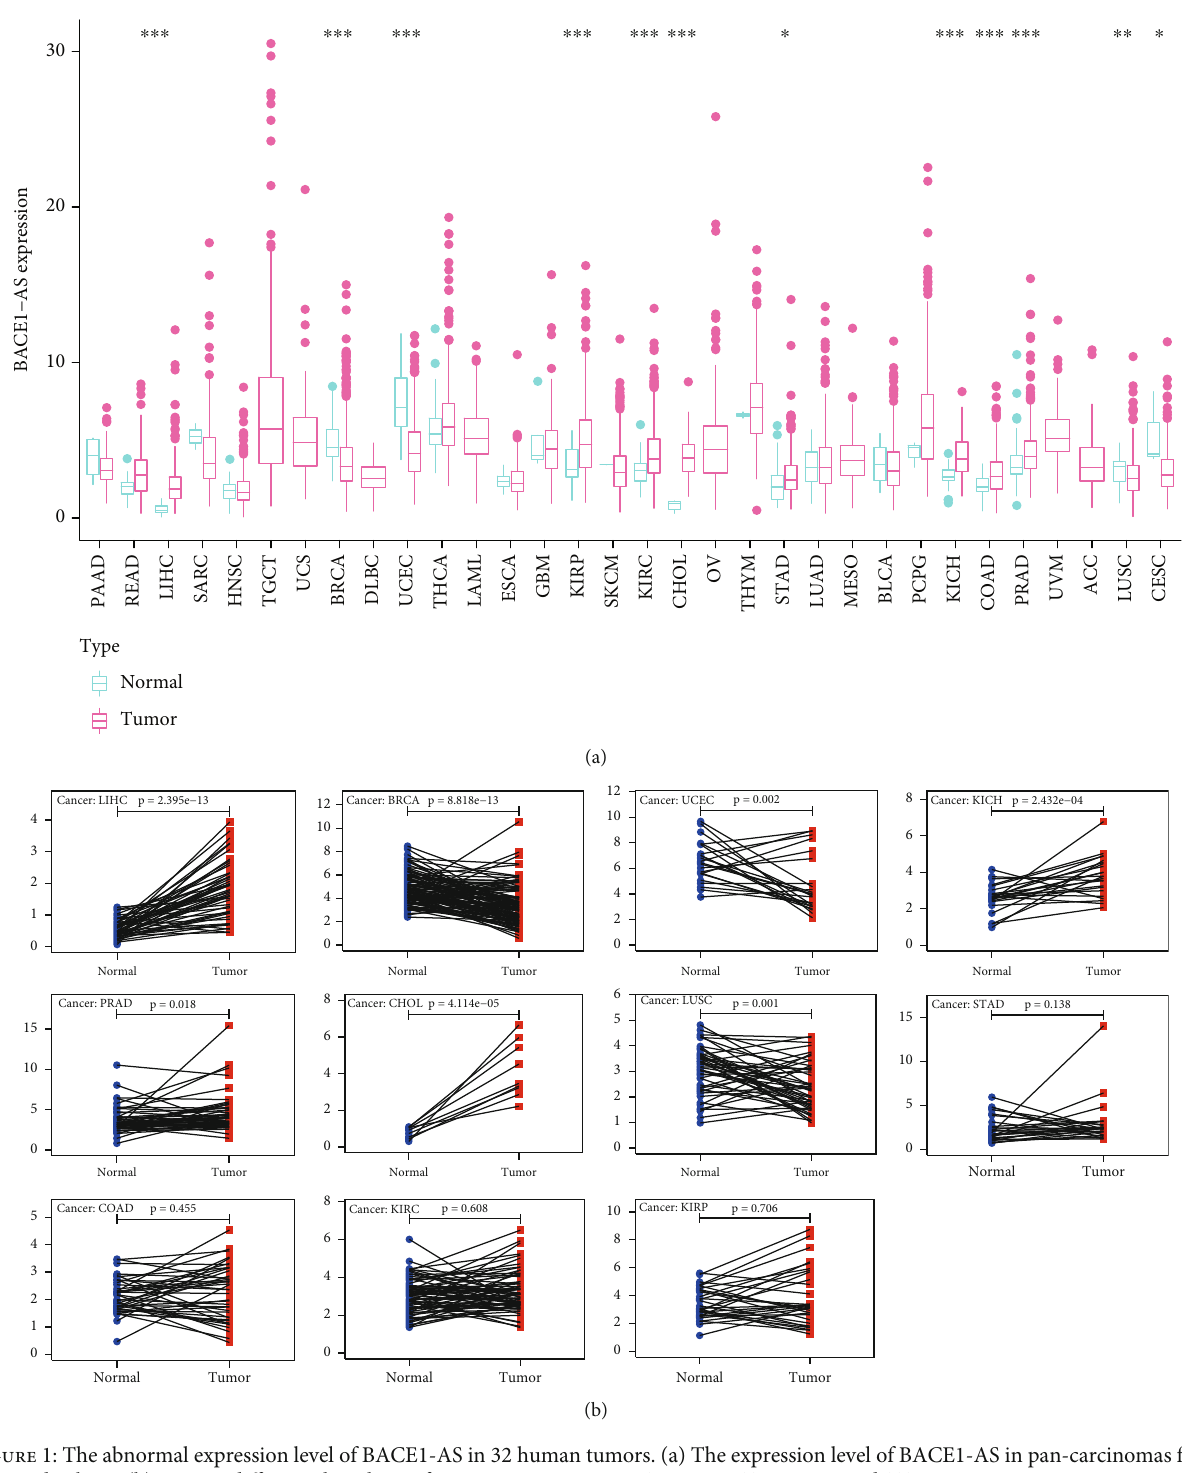
Figure 1: The abnormal expression level of BACE1-AS in 32 human tumors. (a) The expression level of BACE1-AS in pan-carcinomas from TCGA database. (b) Pairing di ff erential analysis of BACE1-AS in tumors. ∗ P < 0 : 05 , ∗∗ P < 0 : 01 , and ∗∗∗ P < 0 : 001 had longer overall survival (OS), while the opposite was 3.2. The Prognostic Value of BACE1-AS in Pan-Cancer. The detected in PAAD and UVM patients (Figure 2(a)). The correlations between BACE1-AS expression levels and the PFI analysis (Figure 2(b)) found that longer progression- prognosis of di ff erent cancers are depicted in Figure 2 free intervals were associated with lower expression of and Supplementary Figure 1. Patients with downregulated BACE1-AS in ACC, LIHC, and PRAD. The DFI results BACE1-AS expression in ACC, COAD, KIRC, and LIHC